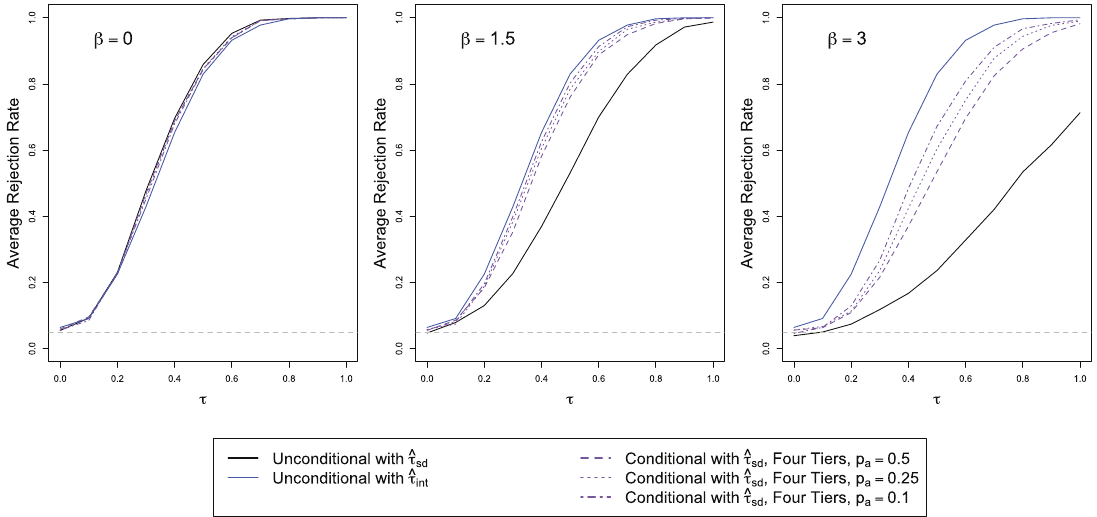
Figure 6: The rejection rate of the same tests discussed in Figure 1, but for an unbalanced design where N T = 25 and N C = 75 instead of a balanced design where N T = N C =